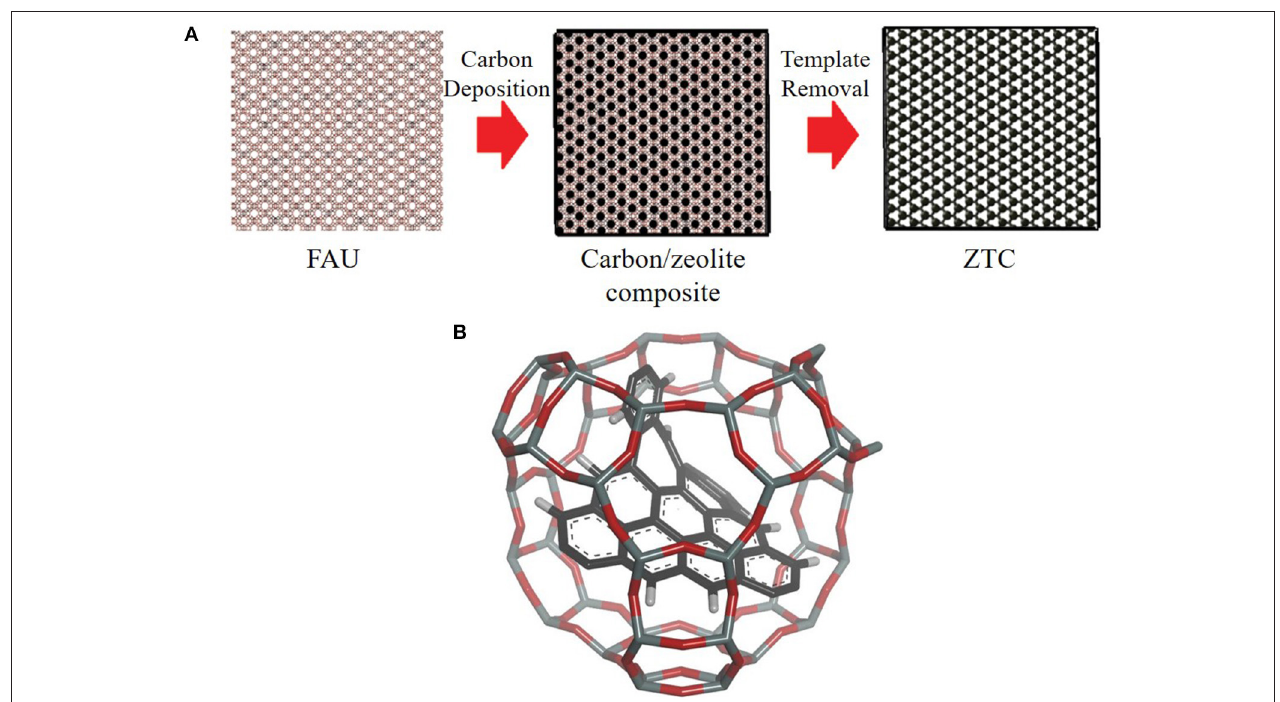
FIGURE 1 | (A) Illustration of chemical vapor deposition on the FAU and (B) structural model of the ZTC embedded inside one supercage of FAU, obtained by CVD method on the micro-FAU (Nishihara et al., 2018). Note that the gray and red sticks represent the FAU framework, whereas the black sticks are for the carbons.